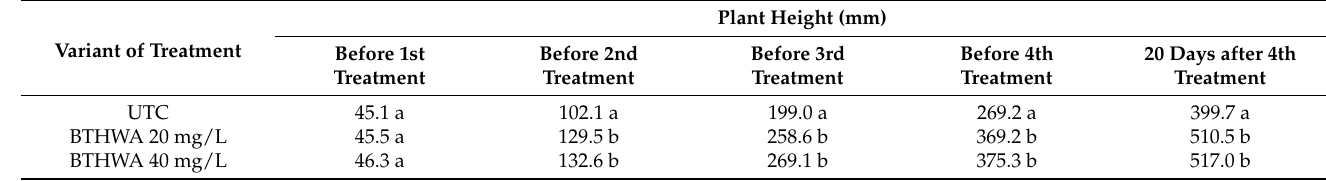
Table 4. Influence of tested variants of treatment on the height of tulips. Variant of